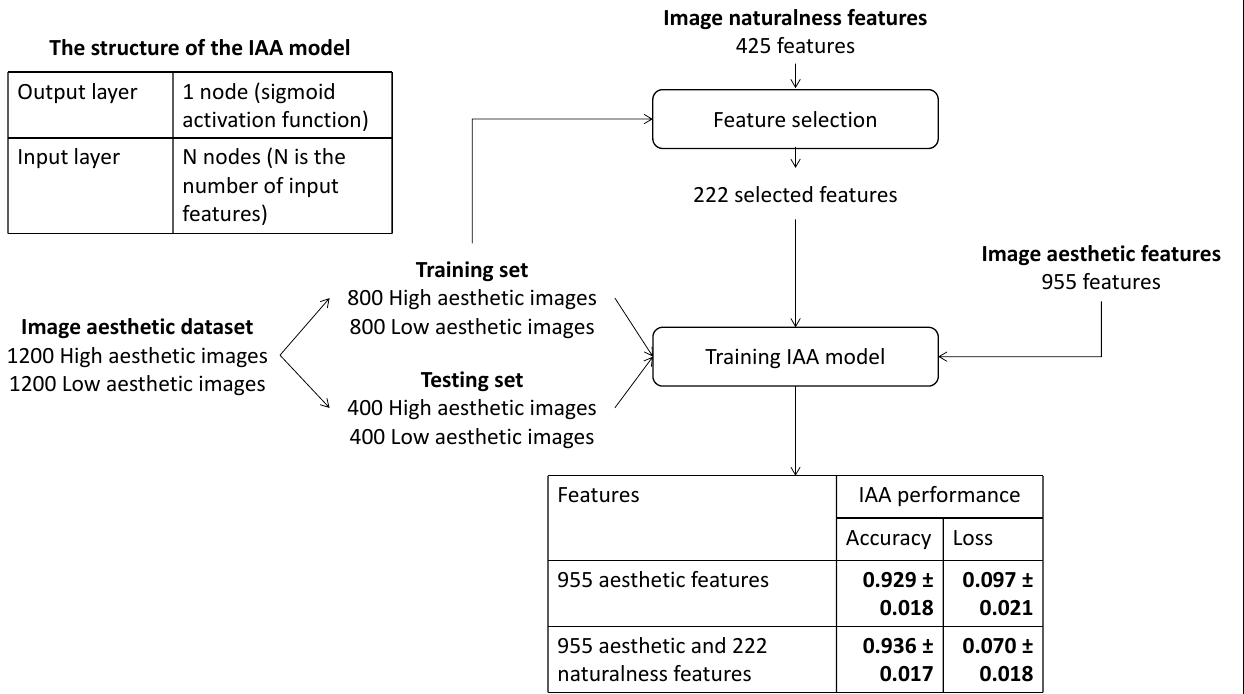
Figure 6. Experiment process of evaluating how IN features improve the performance of